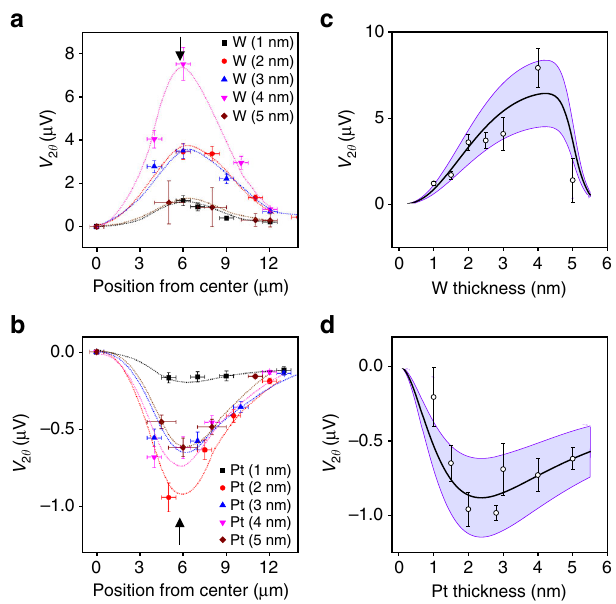
Fig. 3 Thickness dependence of transverse SNMR in W/CoFeB and Pt/ CoFeB structures. a , b Laser-position-dependent thermoelectric signal V 2 θ for W/CoFeB structure ( a ) and Pt/CoFeB structure ( b ) with different HM thicknesses ranging from 1 to 5 nm. Black arrow represents position of edge illumination. c , d HM thickness dependence of the V 2 θ for edge illumination for W/CoFeB structure ( c ) and Pt/CoFeB structure ( d ). The white circles represent experimental data and solid lines represent best fi tted curves, while purple band indicates error ranges of extracted values, which originated from uncertainties of S HM , G , and θ SH . Error bars represent the range of the measured values, resulting from laser-position